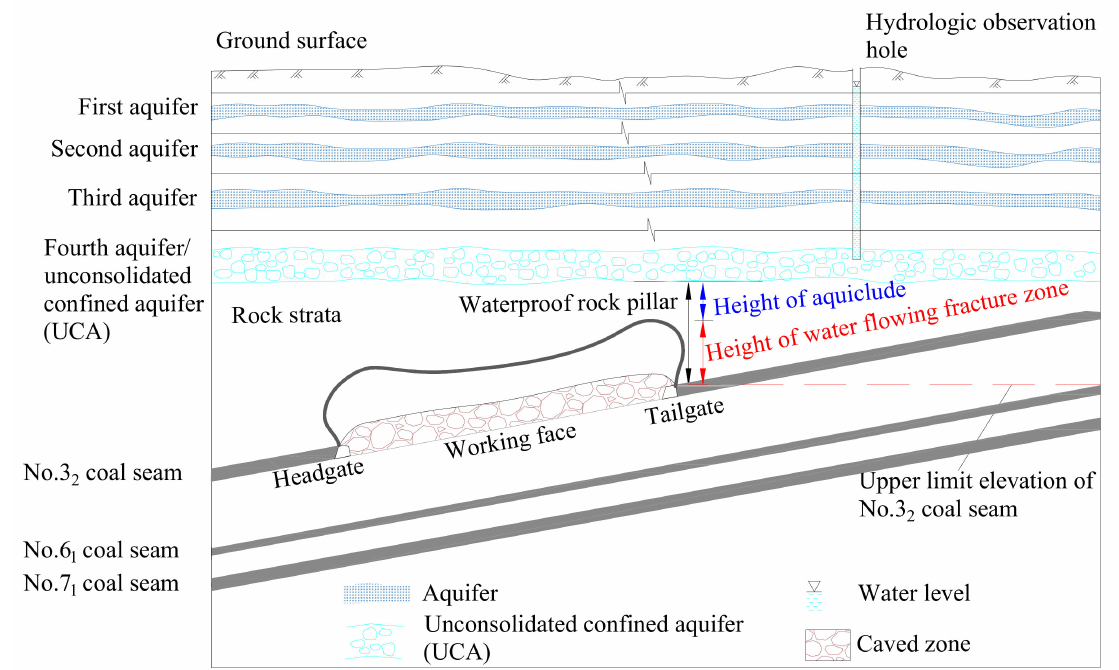
Figure 1. Schematic diagram of waterproof coal/rock pillar/layer for mining under unconsolidated confined aquifer